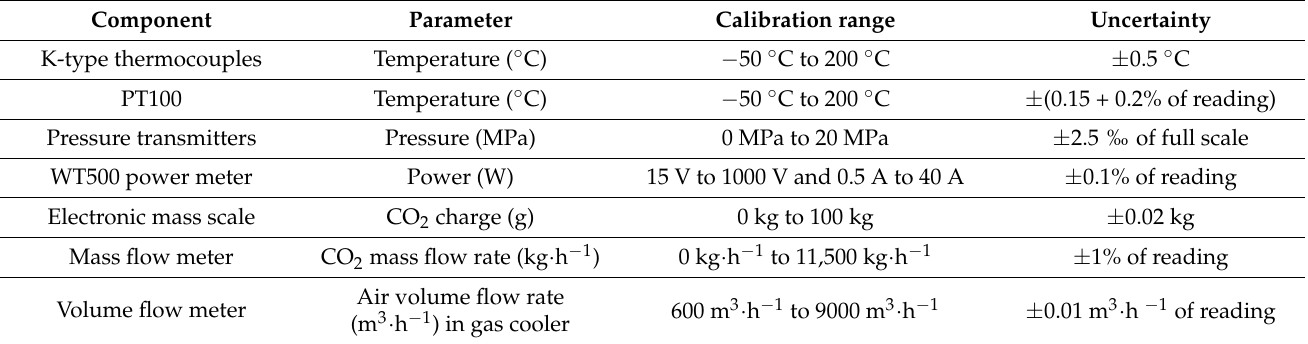
Table 2. Detailed parameters of the measured